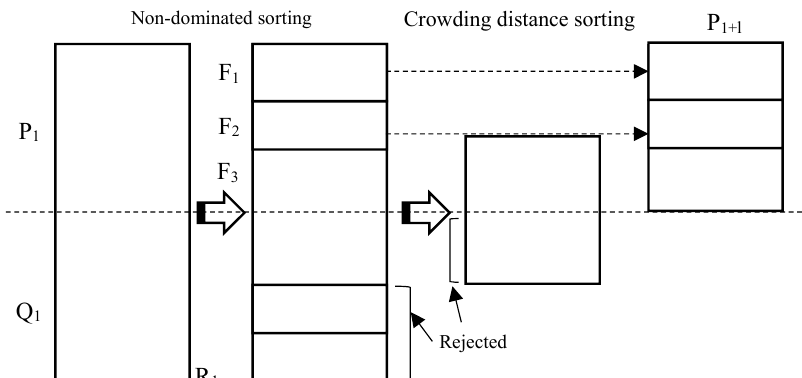
Fig. 5: Arrangement of population in non-dominated sorting genetic algorithm II (NSGA-II) algorithm, where P stands for population, Q represents the population resulted from crossover and mutation, and Fi shows the front.